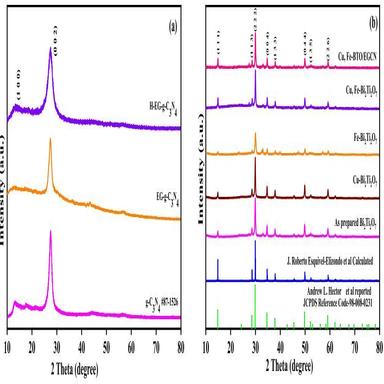
Powder XRD patterns of (a) g-C3N4, EG-g-C3N4, H-EG-g-C3N4, (b) calculated pattern for Bi2Ti2O7 from literature and obtained experimental pattern of Bi2Ti2O7 from this study, Cu-Bi2Ti2O7, Fe-Bi2Ti2O7, Cu, Fe-Bi2Ti2O7, and Cu, Fe-BTO/EGCN.